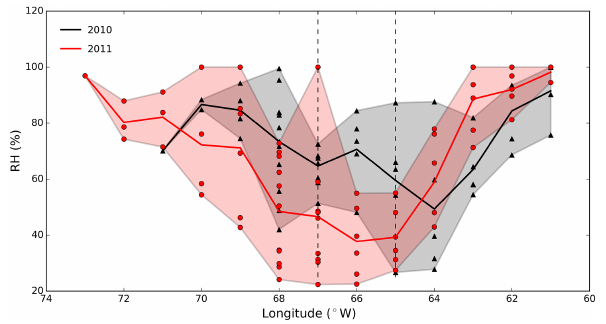
Figure 5. Same as Fig. 4 but for the relative humidity.